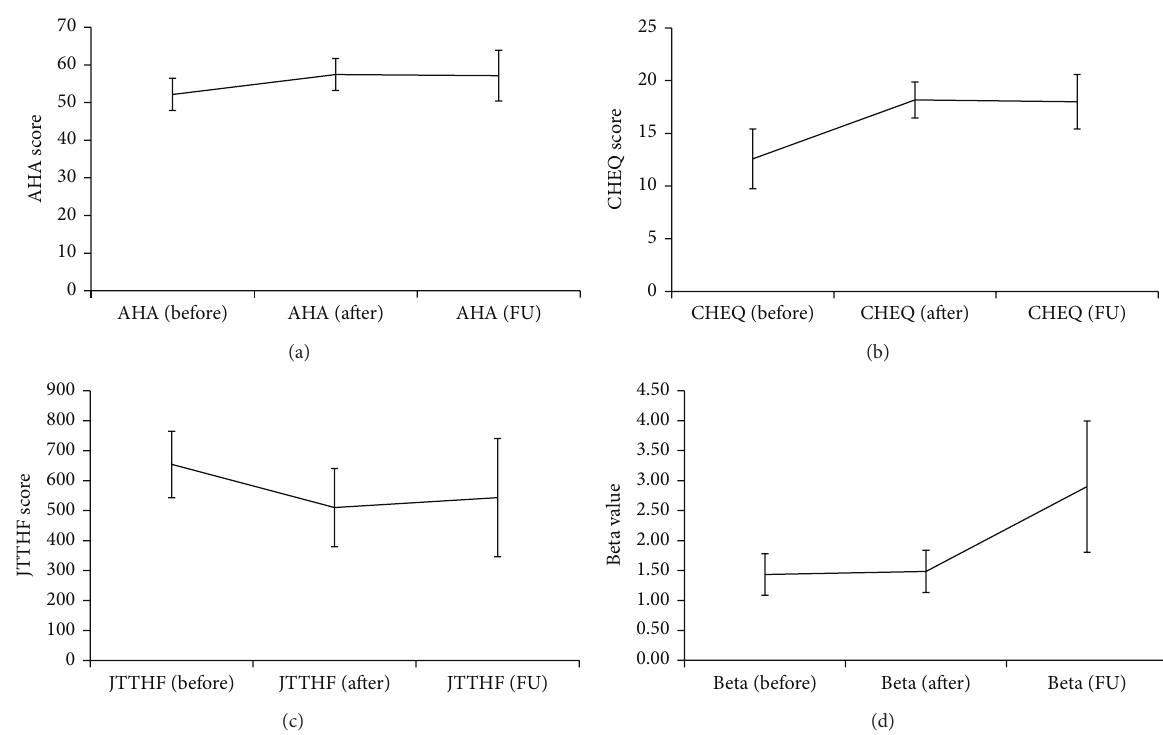
Figure 2: Group means and standard error for (a) AHA, (b) CHEQ number of 2-handed activities, (c) JTTHF of the affected hand, and (d) beta values in affected hemisphere when moving the affected hand. Manual function: before and after, 𝑛 = 12 ; follow-up, 𝑛 = 8 . Betas: before and after, 𝑛 = 7 , follow-up, 𝑛 = 4